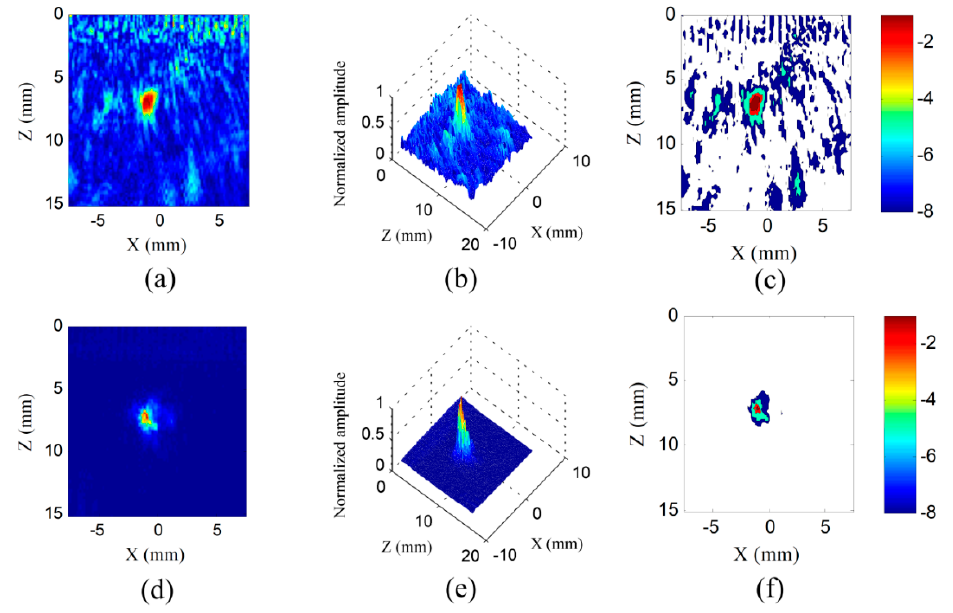
Figure 10. The hybrid full matrix of specimen 1 processed by ( a , b ) TFM and ( d , e ) SCF. Corresponding point-spread functions: ( c ) TFM and ( f ) SCF.